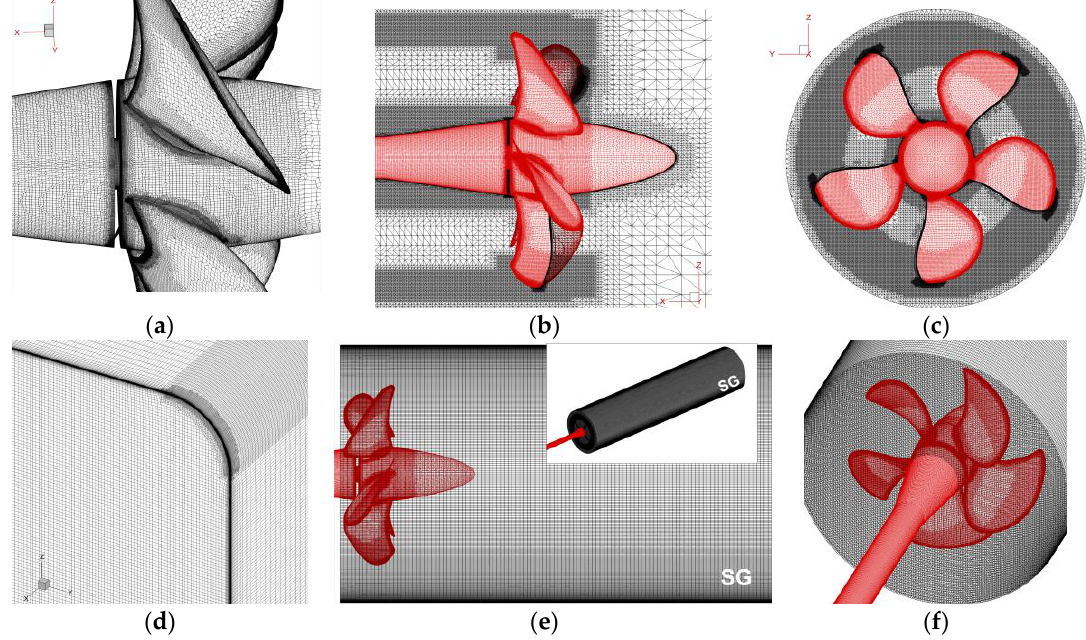
Figure 2. Computational mesh on the PPTC propeller. ( a ): side view detail; ( b ): mesh in the longitudinal plane of symmetry; ( c ): transversal mesh in the propeller plane seen from the suction side; ( d ): viscous boundary layer on the cavitation tunnel walls; ( e , f ): details of the sliding grid used for the cavitation computation.